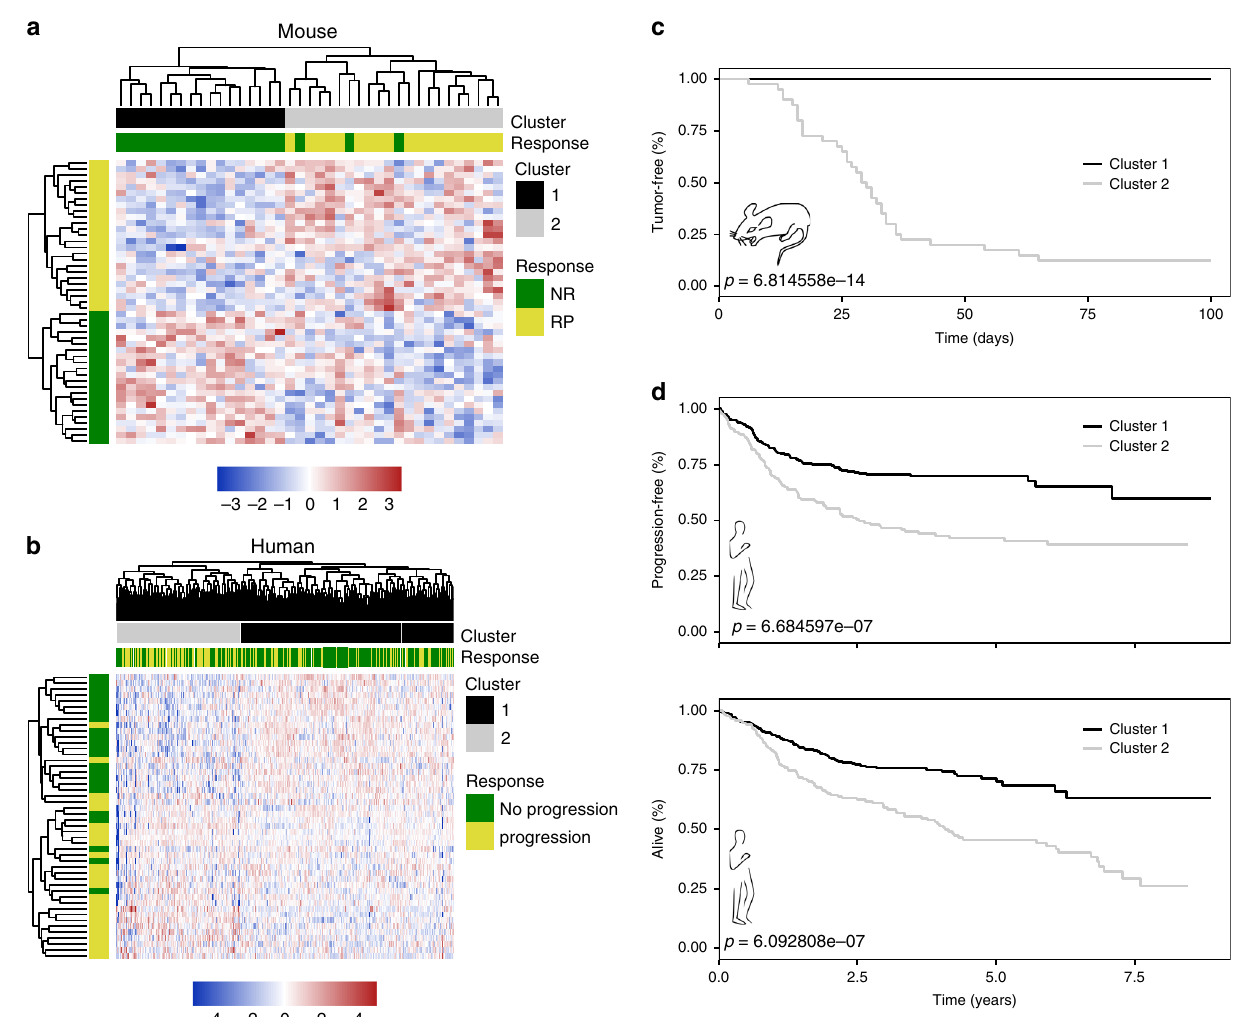
Fig. 2 DLBCL and E µ - myc lymphoma share predictive genes sets. a Heatmap of 39 primary E µ - myc lymphomas based on genes being commonly differentially expressed in non-progressing vs. relapsing DLBCL patients. b Same as in ( a ), but for 470 DLBCL patients (GSE31312). E µ - myc lymphomas and DLBCL patients were separated into two clusters by hierarchical clustering using Pearson ’ s distance correlation and complete linkage. Because of little very high and very low z -scores, they were restricted to the interval [ − 5,5] after hierarchical clustering for presentation purposes only. c Tumor-free survival of CTX-treated E µ - myc lymphomas strati fi ed by two hierarchical clusters ( n cluster 1 = 34, n cluster 2 = 42) as shown in ( a ). Two mice per lymphoma were used. d Progression-free and overall survival of R-CHOP-treated DLBCL patients strati fi ed by the two hierarchical clusters as shown in ( b ) ( n cluster 1 = 297, n cluster 2 =